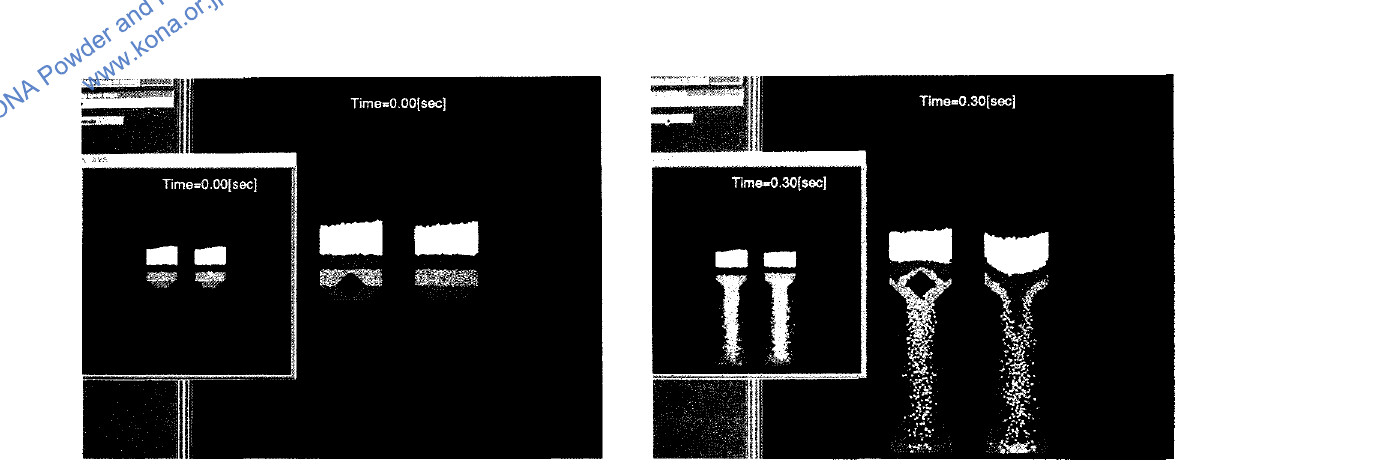
Fig. 7 Particles discharging from a cylindrical hopper (Comparison between two cases with and without an inserted cone, Pictures in the large frame show the view in the vertical central plane inside the hopper. Pictures in the small frame show side views.)